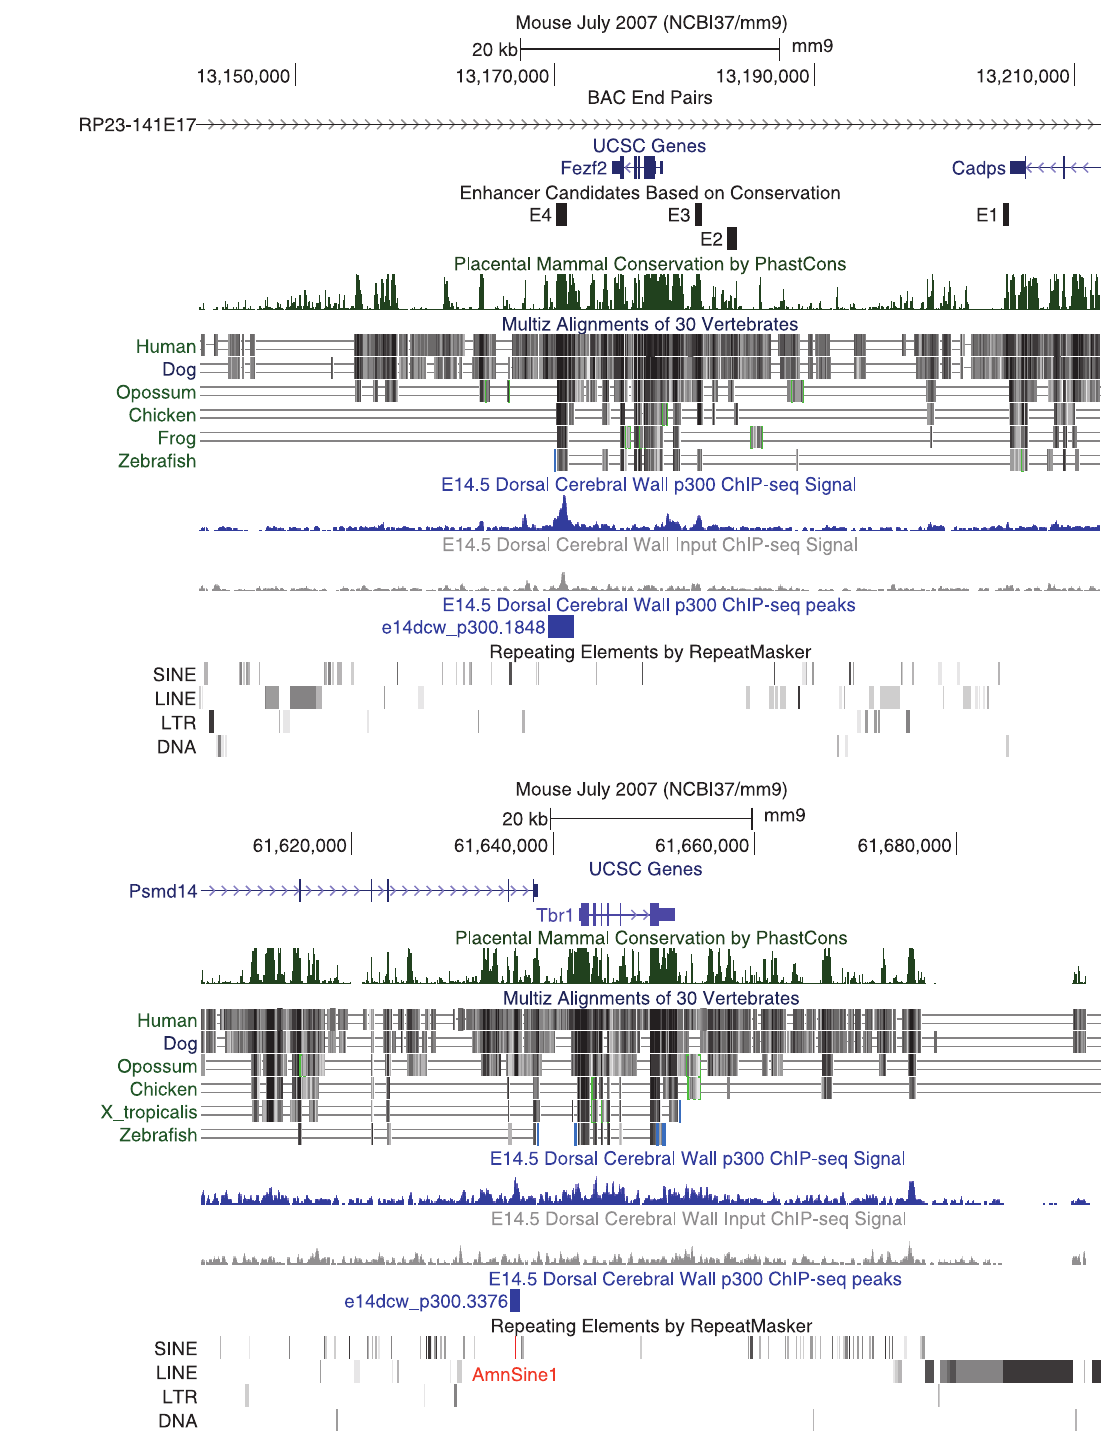
Figure 7. p300 peaks next to key neocortical developmental genes. A) A single E14.5 p300 peak (blue) is found in 180 kb of the RP23-141E17 BAC investigated in [8]. This peak contains the E4 developmental enhancer whose genomic deletion leads to aberrant cortico-spinal projection fates, similar to those found in its Fezf2 target gene conditional knock-out. As suggested by our data, only deletion of E4, but not E1, E2 or E3 from the BAC resulted in reduced neocortical expression from the Fezf2 locus. B) Tbr1 and Fezf2 act antagonistically to determine cortical neuron projection fates. A single E14.5 p300 peak is found proximal to the Tbr1 gene. This pan-mammalian conserved peak has likely been seeded by the co-option of an AmnSine1 instance (red) at its center.